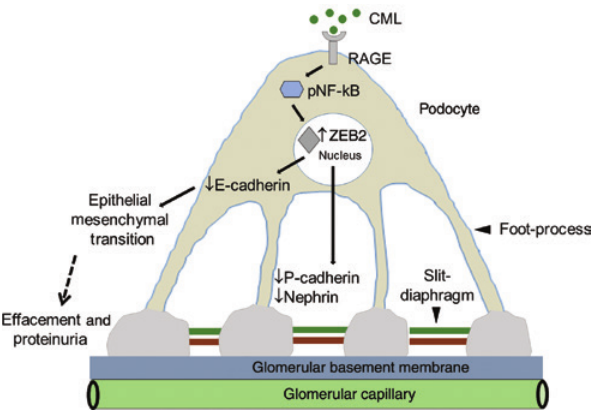
Figure 4: The mechanism by which CML induces podocyte injury and